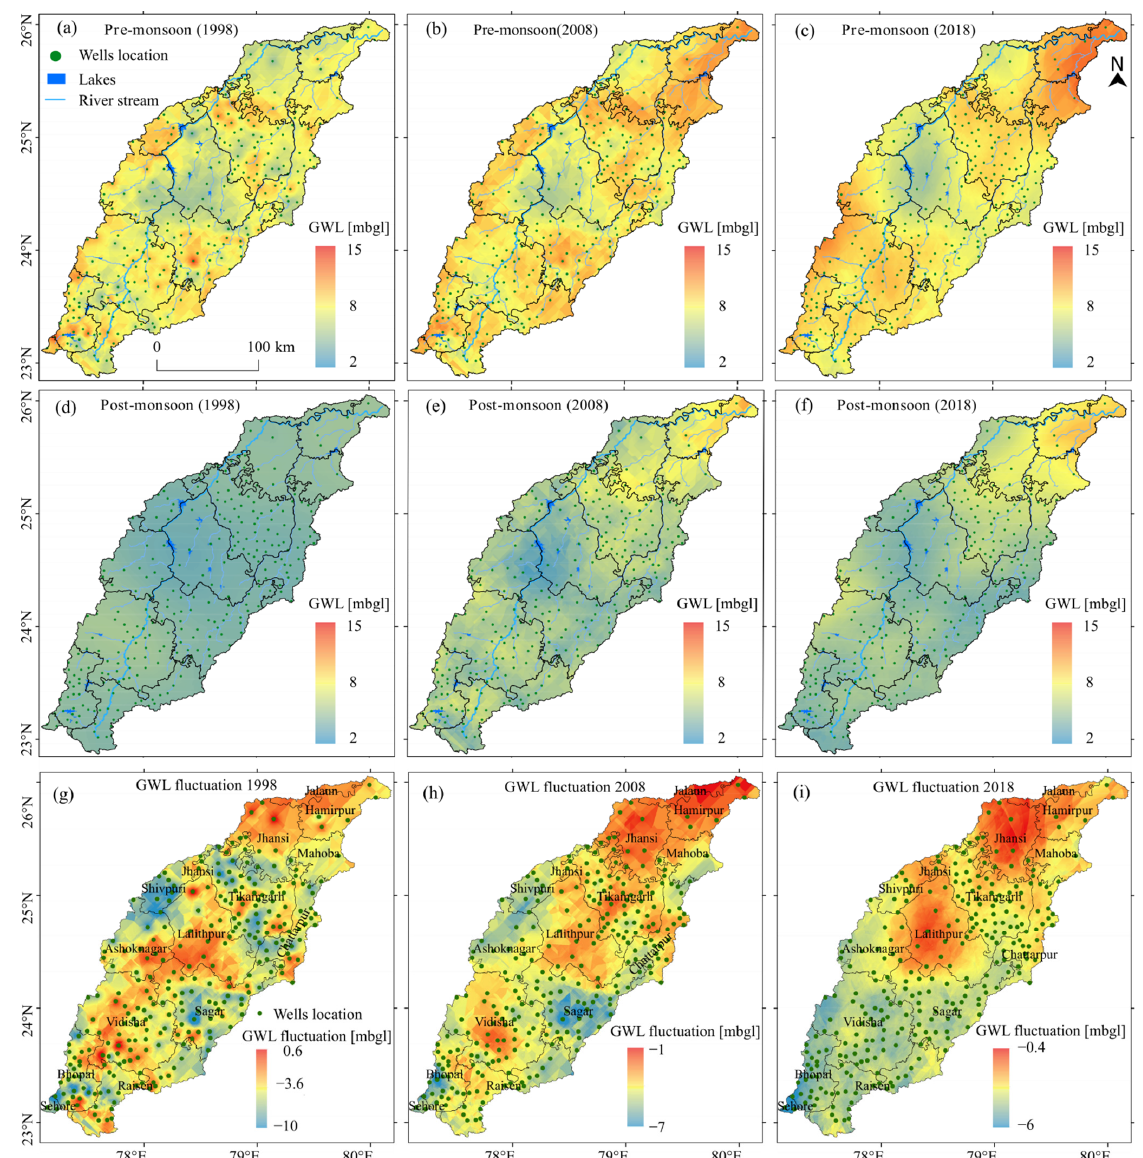
Figure 4. The spatial distribution of the GWL images on the top represents the pre ‐ monsoon period of 1998, 2008, and 2018 ( a – c ). Images in the middle represent GWL during the post ‐ monsoon period 1998, 2008, and 2018 ( d – f ). The bottom three images show the annual groundwater change (fluctuation) from post ‐ monsoon to pre ‐ monsoon for 1998, 2008, and 2018 ( g – i ).